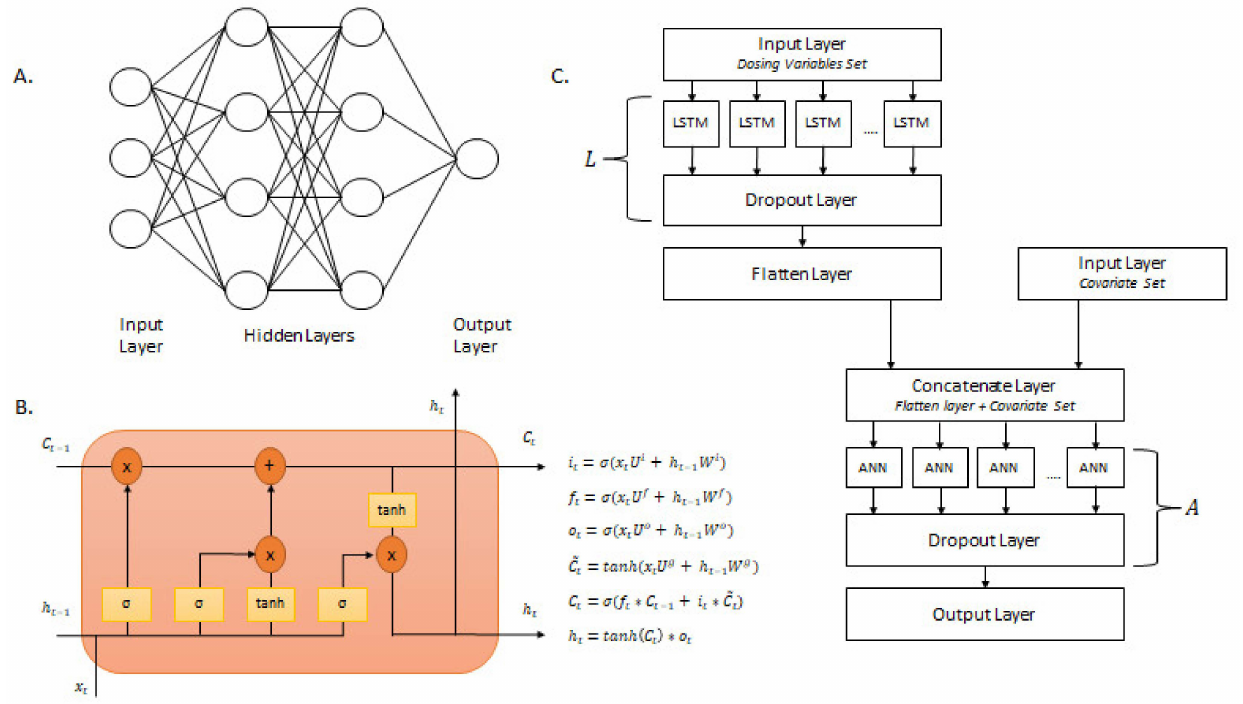
Figure 3. Model architecture of Deep Learning models. ( A ) Structure of an artificial neural network with an input layer, hidden layer, and an output layer; ( B ) Structure of the LSTM cell and the equations that refer to the gates of the LSTM cell; ( C ) Schematic of the LSTM-ANN model. Each box represents a different layer within the Deep Learning